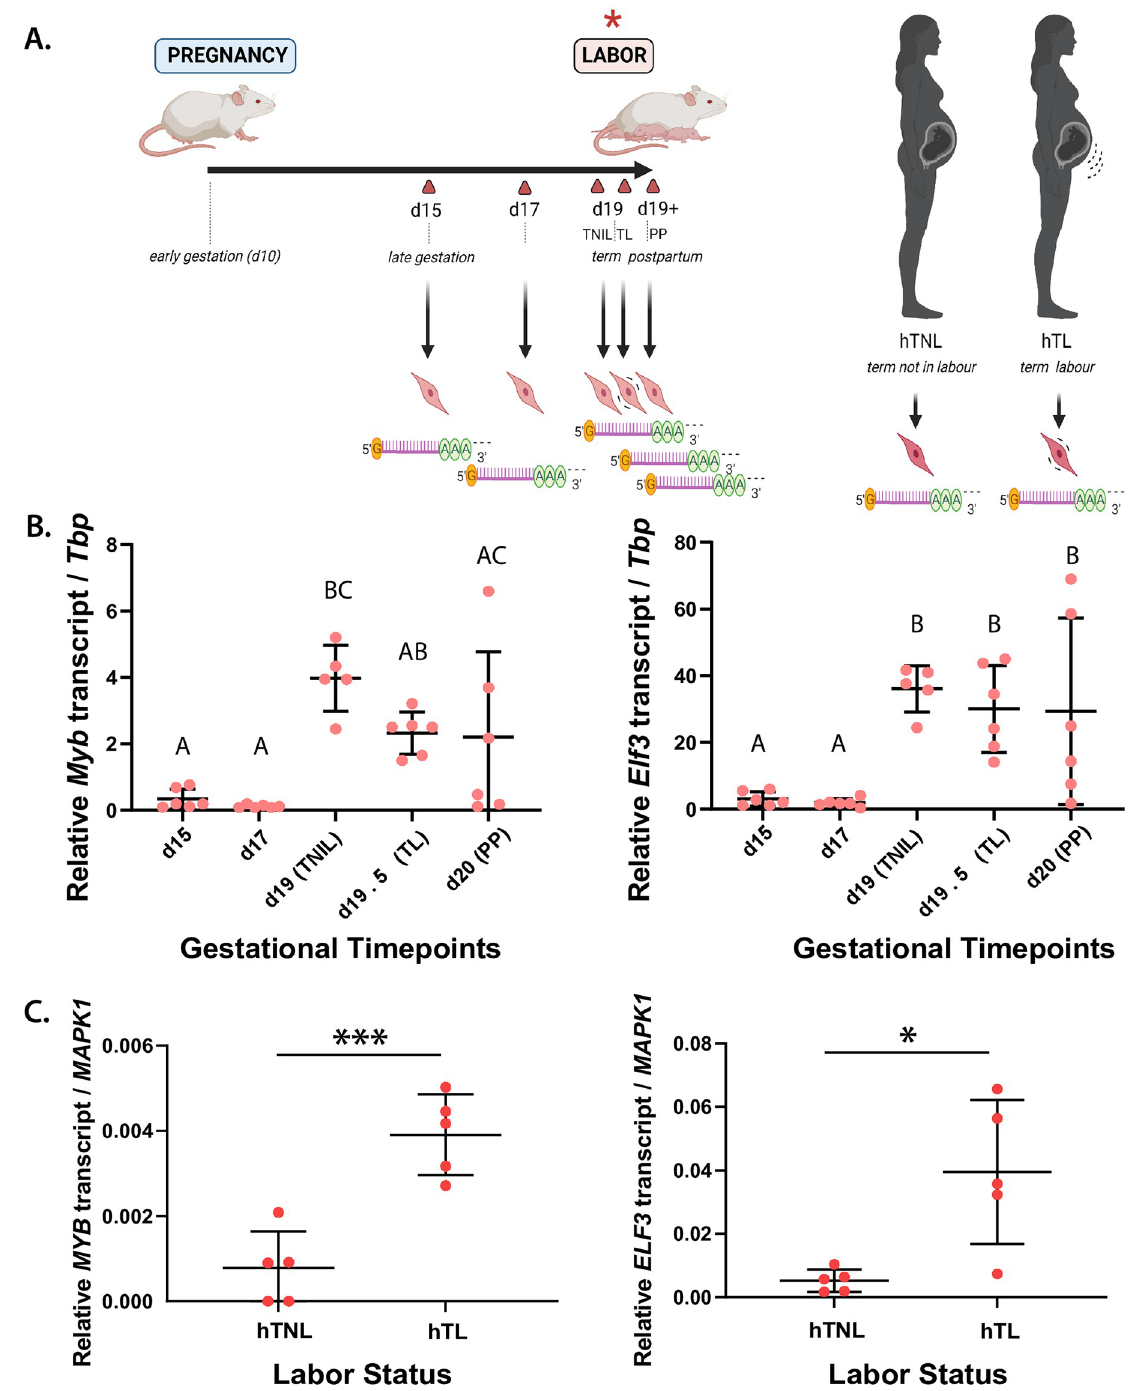
Fig 1. MYB and ELF3 are differentially expressed in CD-1 mouse and human myometrial tissues in vivo depending on labor status. (A) (left) Schematic of gestational time points for myometrial tissue collection from CD-1 mice. Gestational days (d) at which tissues were collected marked by triangles (red), with indication of term non-laboring (TNIL), term laboring (TL) and postpartum (PP) mouse myometrium alongside key gestational stages ( italicized ). (right) Schematic of RNA collection from human myometrial tissues, from either the term non-laboring (hTNL) or term laboring (hTL) women. (B) Expression levels ( ± S.D.) of transcription factor-encoding genes at d15, d17, d19 (TNIL), d19.5 (TL), and d20 (PP) time points, as determined by RT-qPCR. Groups determined by one-way ANOVA to be significantly different (p < 0.05) from one another are labeled with different letters; to indicate p > 0.05, groups are labeled with the same letter. (C) Expression levels ( ± S.D.) of transcription factor-encoding genes in human TNL and TL myometrium, as determined by RT- qPCR. Statistically significant differences in expression levels between time points are marked by � p < 0.05, ��� p < 0.005.